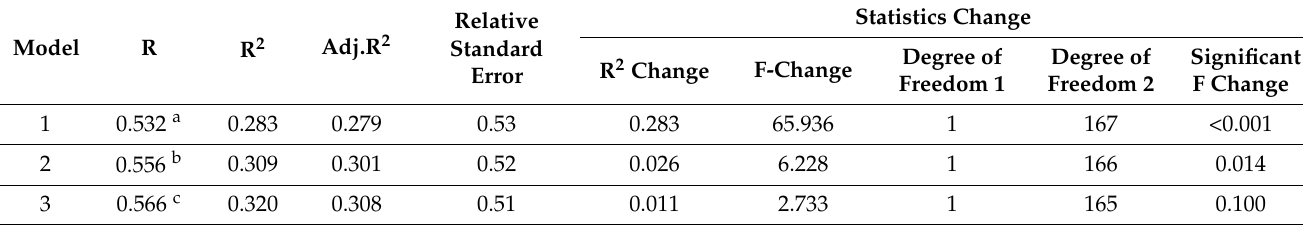
Table 4. Moderating effect of emotional self-disclosure in the relationship between depression and QOL ( n = 169).